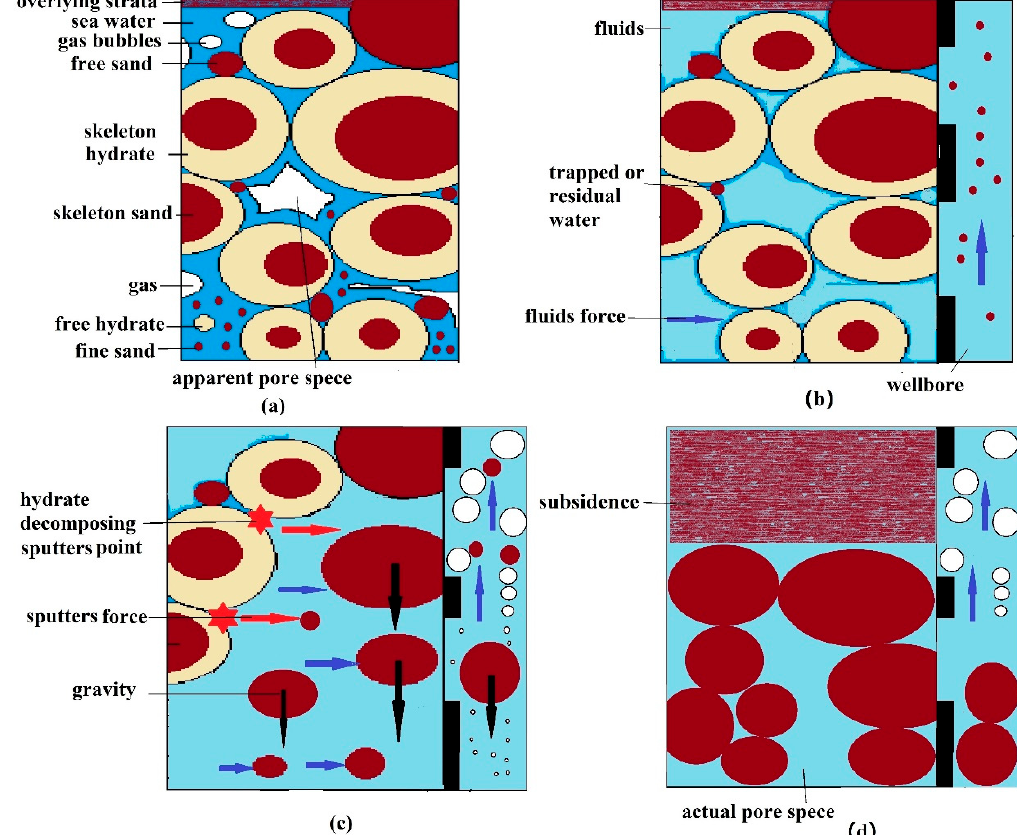
Figure 8. Mechanism for hydrate sand production in the three production period, ( a ) the initial state of hydrate-bearing-sediments; ( b ) the fine sand production in the first production period; ( c ) hydrate decomposition and sand production in the second period; ( d ) the final state decomposition and sand production in the second period; ( d ) the final state hydrate-bearing-sediments hydrate-bearing-sediments in the third production period . in the third production